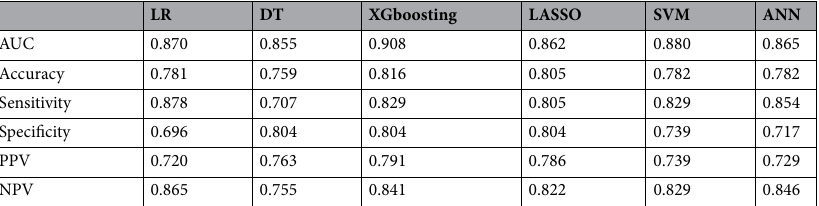
Table 3. Performance of machine learning algorithms for the prediction of febrile neutropenia. LR logistic regression, DT decision tree, LASSO least absolute shrinkage and selection operator, SVM support vector machine, ANN artificial neural network, AUC area under the curve, PPV positive predictive value, NPV negative predictive value.